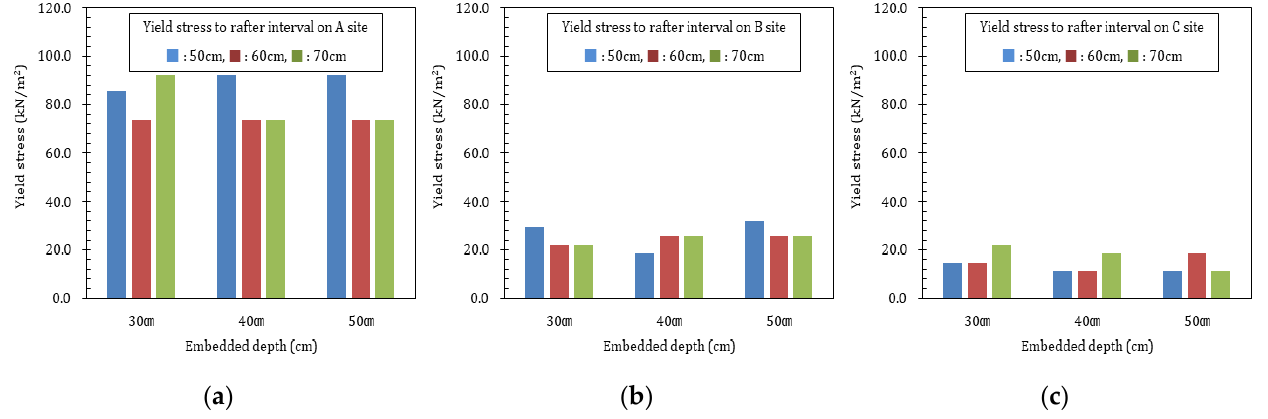
Figure 13. Yield stress to rafter spacing on site A, site B, and site C: ( a ) yield stress to rafter spacing on site A; ( b ) yield stress to rafter spacing on site B; ( c ) yield stress to rafter spacing on site C.